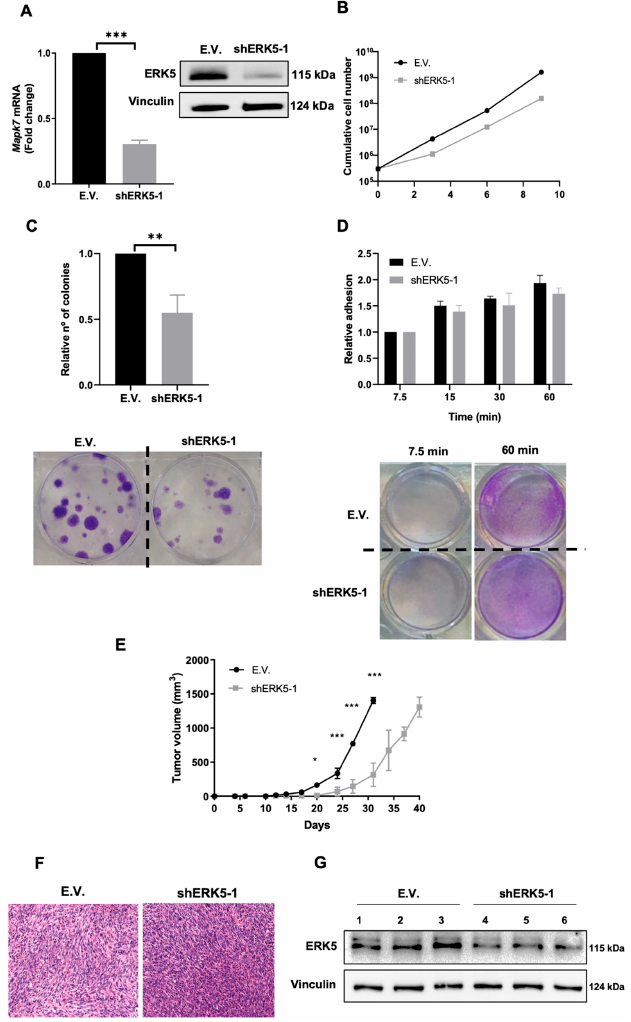
Figure 3. ERK5 modulates in vitro and in vivo growth of 3MC-C1 cell line. ( A ) 3MC-C1 cells were infected with lentiviruses carrying PLKO.1 empty vector (E.V.) or the PLKO.1-shRNA ERK5-1 vector (shERK5-1). Interference was evaluated by RT-qPCR using β -2-microglobulin (B2m ) as an endogenous control ( left panel). E.V. cells were considered as 1. Right panel shows a representative image of the interference by western blot using vinculin as a loading control. ( B ) For growth curves, 3 × 10 5 E.V. or shERK51 3MC-C1 cells were seeded in 100 mm plates. Every 3 days, cells were counted and replated in the same manner up to day 9. Graphic shows the cumulative cell number from a representative experiment out of 3 with nearly identical results in different pools of infections. ( C ) Upper panel: Relative number of colonies obtained in clonogenic assays of E.V. and shERK5-1 3MC-C1 cells. Lower panel: Representative image of a colony formation assay from both cell lines. ( D ) Upper panel: Relative adhesion of E.V. or shERK5-1 3MC-C1 cells was assessed by crystal violet staining at the indicated time points. Lower panel: Representative image of adhesion assays at 7.5 and 60 min. ( E ) Nude mice (n = 4) were inoculated with 5 × 10 5 cells of each cell line derived from 3MC-C1, and tumorigenesis was analyzed at indicated times. Graphics represent the mean ± SD. The experiment was performed by using another pool of infection with nearly identical results. ( F ) Western blot analysis of the expression level of ERK5 in tumors recovered from 3MC-C1 E.V. and shERK5-1. Vinculin was used as a loading control. ( G ) Representative images of the histological study of tumors obtained from 3MC-C1 derived cell lines. Pictures are shown at a 20 × magnification. The graphs/histograms represent the mean ± SD of 3 independent experiments performed in triplicate cultures with different pools of infections, if not otherwise indicated. Original blots could be found in Figure S7. * p < 0.05; ** p < 0.01; and *** p <